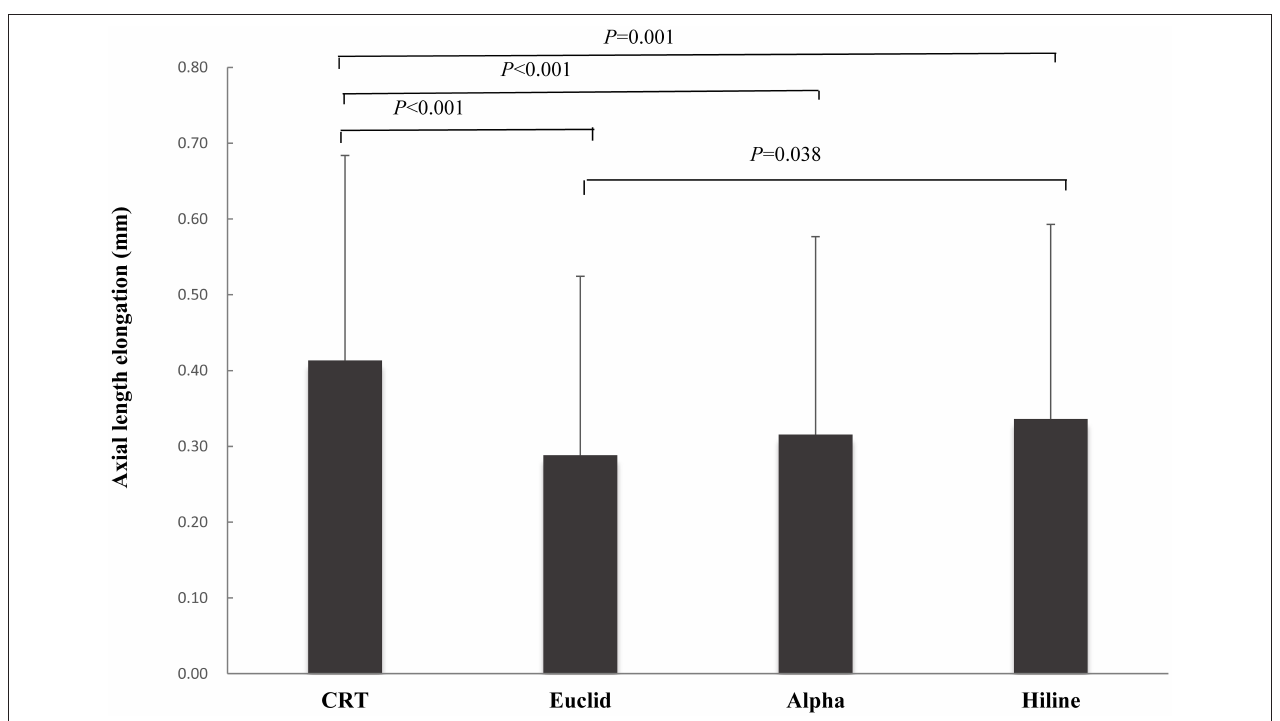
FIGURE 1 | Comparison of axial length elongation after one and a half years of orthokeratology (OK) lens wear between four different lens types.